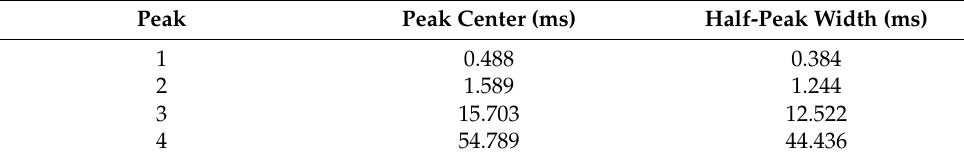
Table 2. Selected fitting peak center and half-peak width. Peak